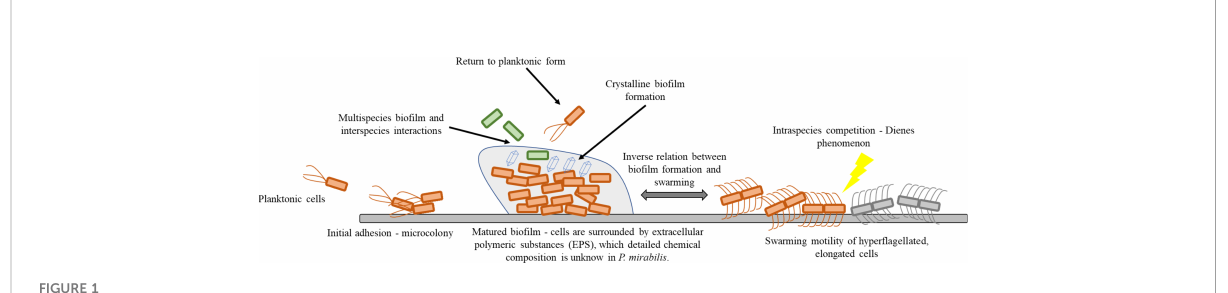
FIGURE 1 Schematic presentation of Proteus mirabilis lifestyle on solid